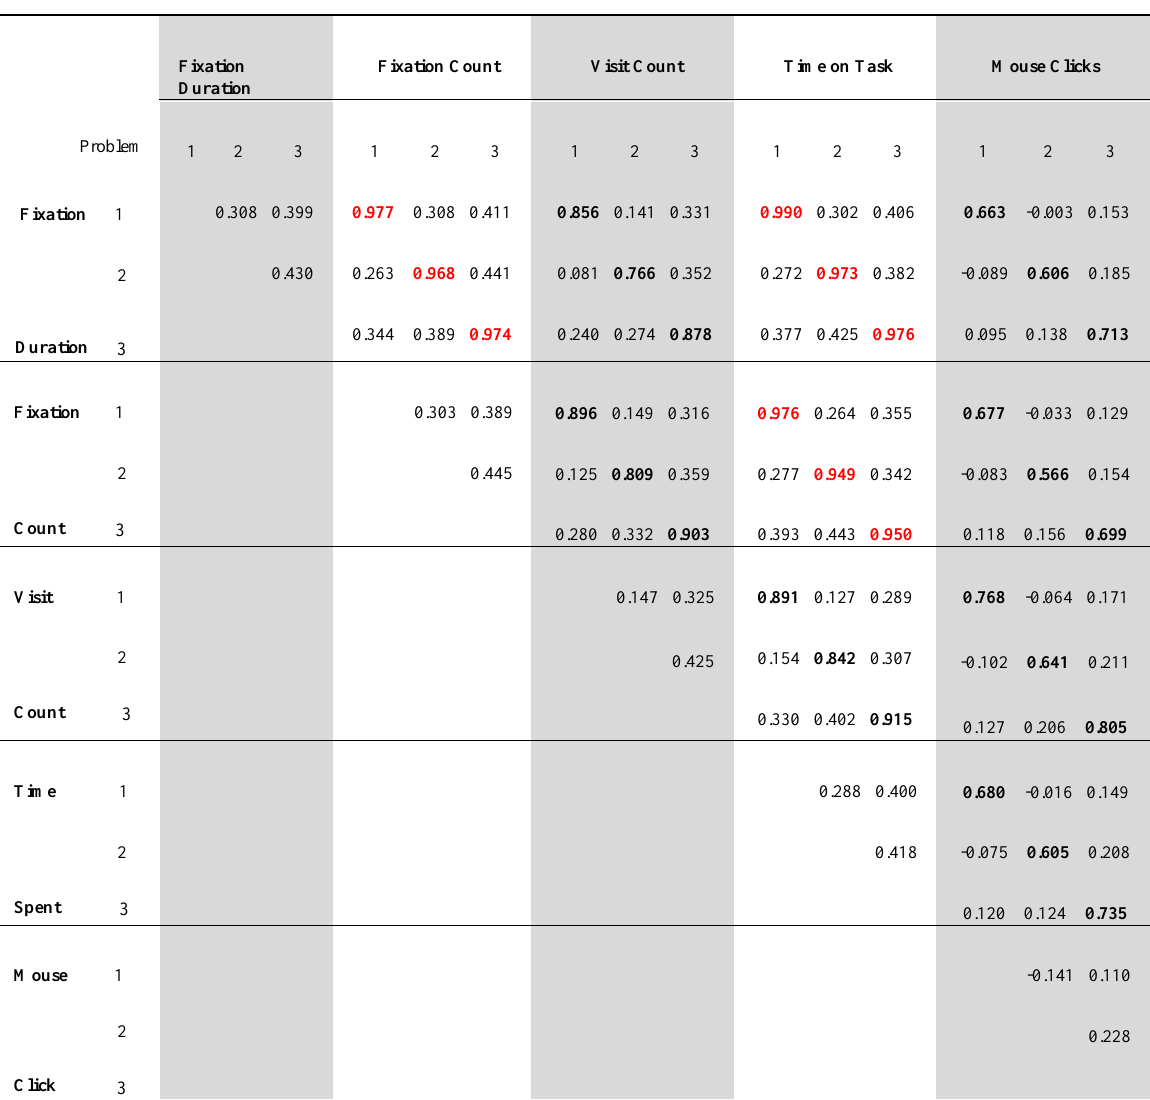
Correlation matrix of fixation duration, fixation count, visit count, time on task and mouse click in each of the three